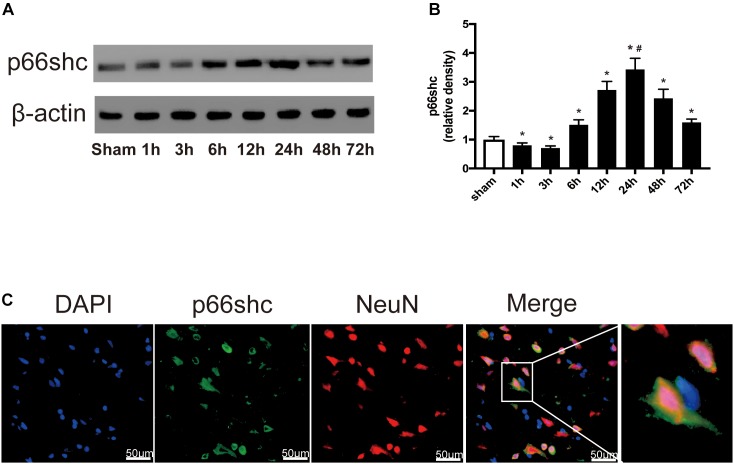
(A) Representative Western blot bands of p66shc at different time course in ipsilateral basal cortex after subarachnoid hemorrhage (SAH) induction. (B) Quantitative analysis of p66shc expression. n = 6 for each group. The bars represent the mean ± SD. ∗P < 0.05 versus sham, #P < 0.05 versus every other group. The densities of the protein bands were analyzed in relation to β-actin and normalized to the sham group. (C) Representative microphotographs of immunofluorescence staining showing localization of p66shc (green) with NeuN (red) in ipsilateral basal cortex of SAH 24 h group (scale bar = 50 μm). The rightmost image was magnified by digital zoom.